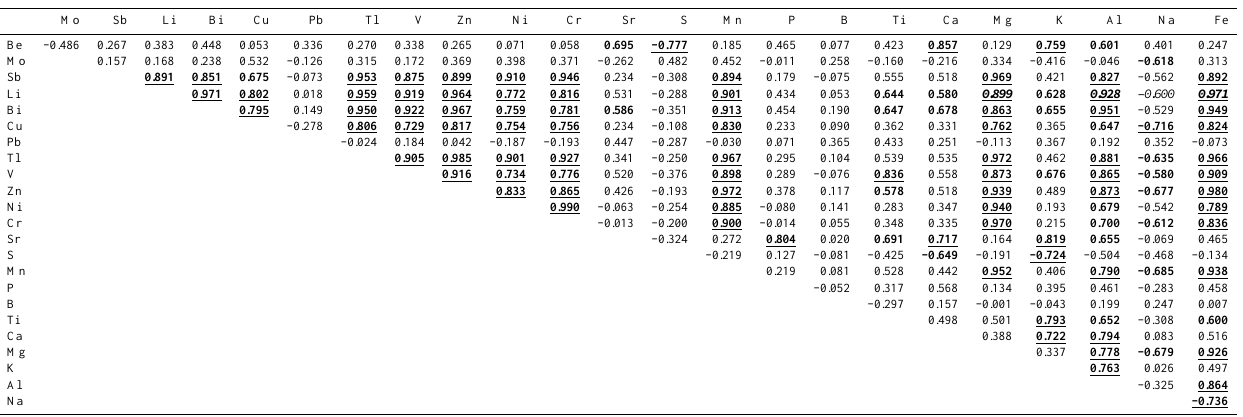
Table 6. Pearson correlation coefficients among elements (mgkg − 1 ) in the samples of colluvium profiles. Bold face numbers are significant at the 95% confidence level, underlined numbers are significant at the 99% confidence